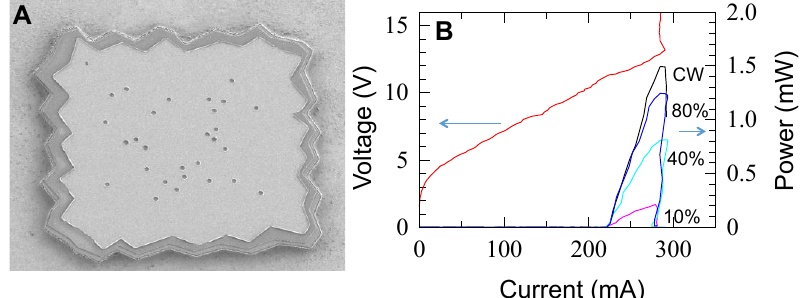
Figure 1: (A) Scanning electron microscope (SEM) image of the investigated random QCL resonator having an area of 0.06 mm 2 , and patterned surface holes of 6 μ m diameter.(B)Light-current (L-I)andvoltage- current (V-I) characteristics as a function of the duty cycle or under CW operation measured on the device shown in panel (A), having area of 0.06 mm 2 , hole diameter 6 μ m and fi lling factor r/a = 11%, where r is the hole radius and a the average